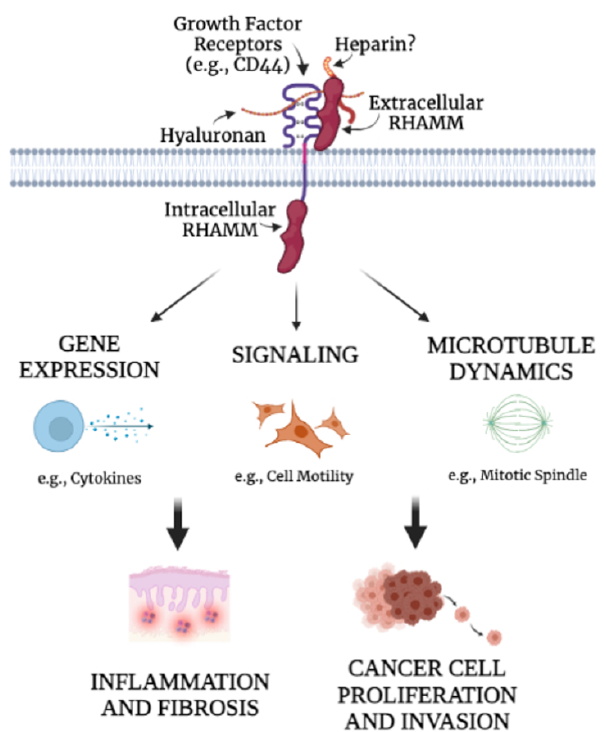
Figure 8. The interaction between cell surface RHAMM and HA is proposed to activate the multiple functions of extracellular and intracellular RHAMM. Since RHAMM plays a critical role in many HA-mediated functions, using reagents to target the HA-binding region of RHAMM is expected to reduce the pathologies associated with RHAMM activation.